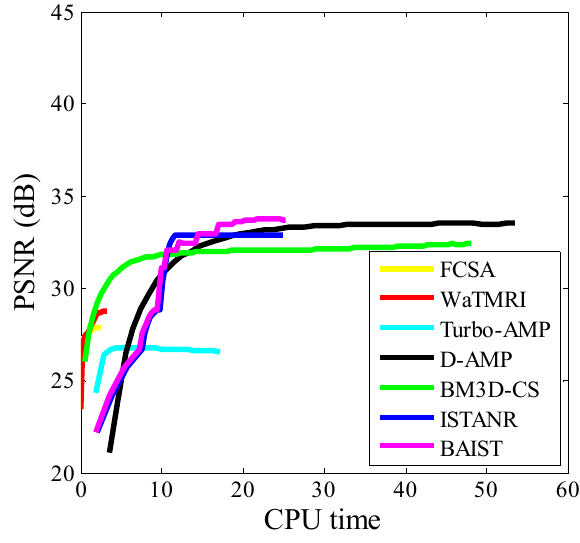
Figure 5. CPU time vs. PSNR on boat image with 20% sampling.